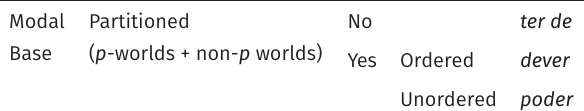
Table 1: Epistemic modal verbs in Portuguese and Modal